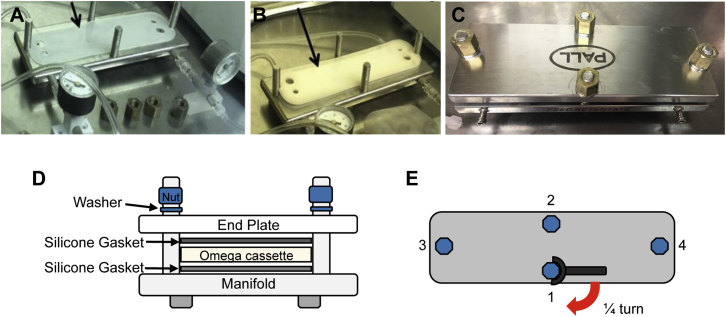
Assembly of TFF Cassette(A) Bottom plastic gasket placed on top of the manifold. (B) Cassette placed on top of bottom gasket, followed by another plastic gasket on top (not shown). (C) Final Centramate setup with end plate and nuts in place. (D) Side view of the final Centramate setup showing placement of the two gaskets and the cassette. (E) A representation of the order in which to tighten bolts 1 → 4. Tighten each nut by one-fourth of a turn each time so as to avoid uneven pressure on one section of the cassette and subsequent damage.